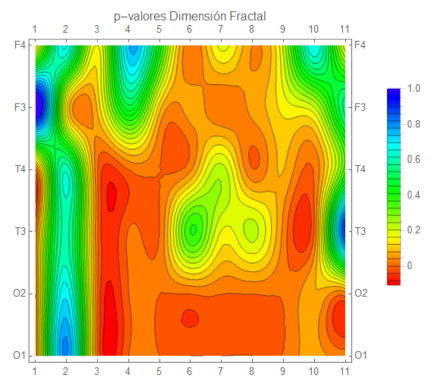
Figure 6. p -values obtained in the pairwise comparison hypothesis test of the EEG types ( X -axis) in each channel ( Y